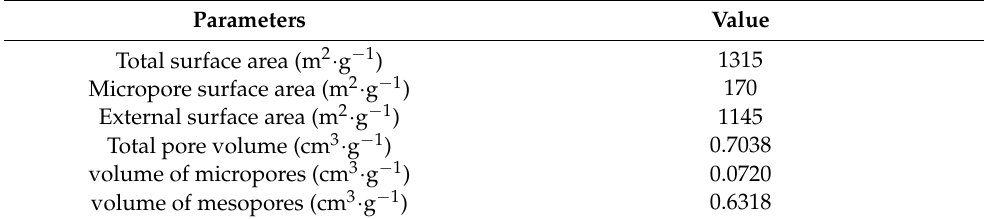
Figure 1. ( a ) Isotherm of adsorption and desorption of N 2 ; ( b ) Pore size distribution curve. Table 1. Specific surface area and pore volume of ABC carbon.